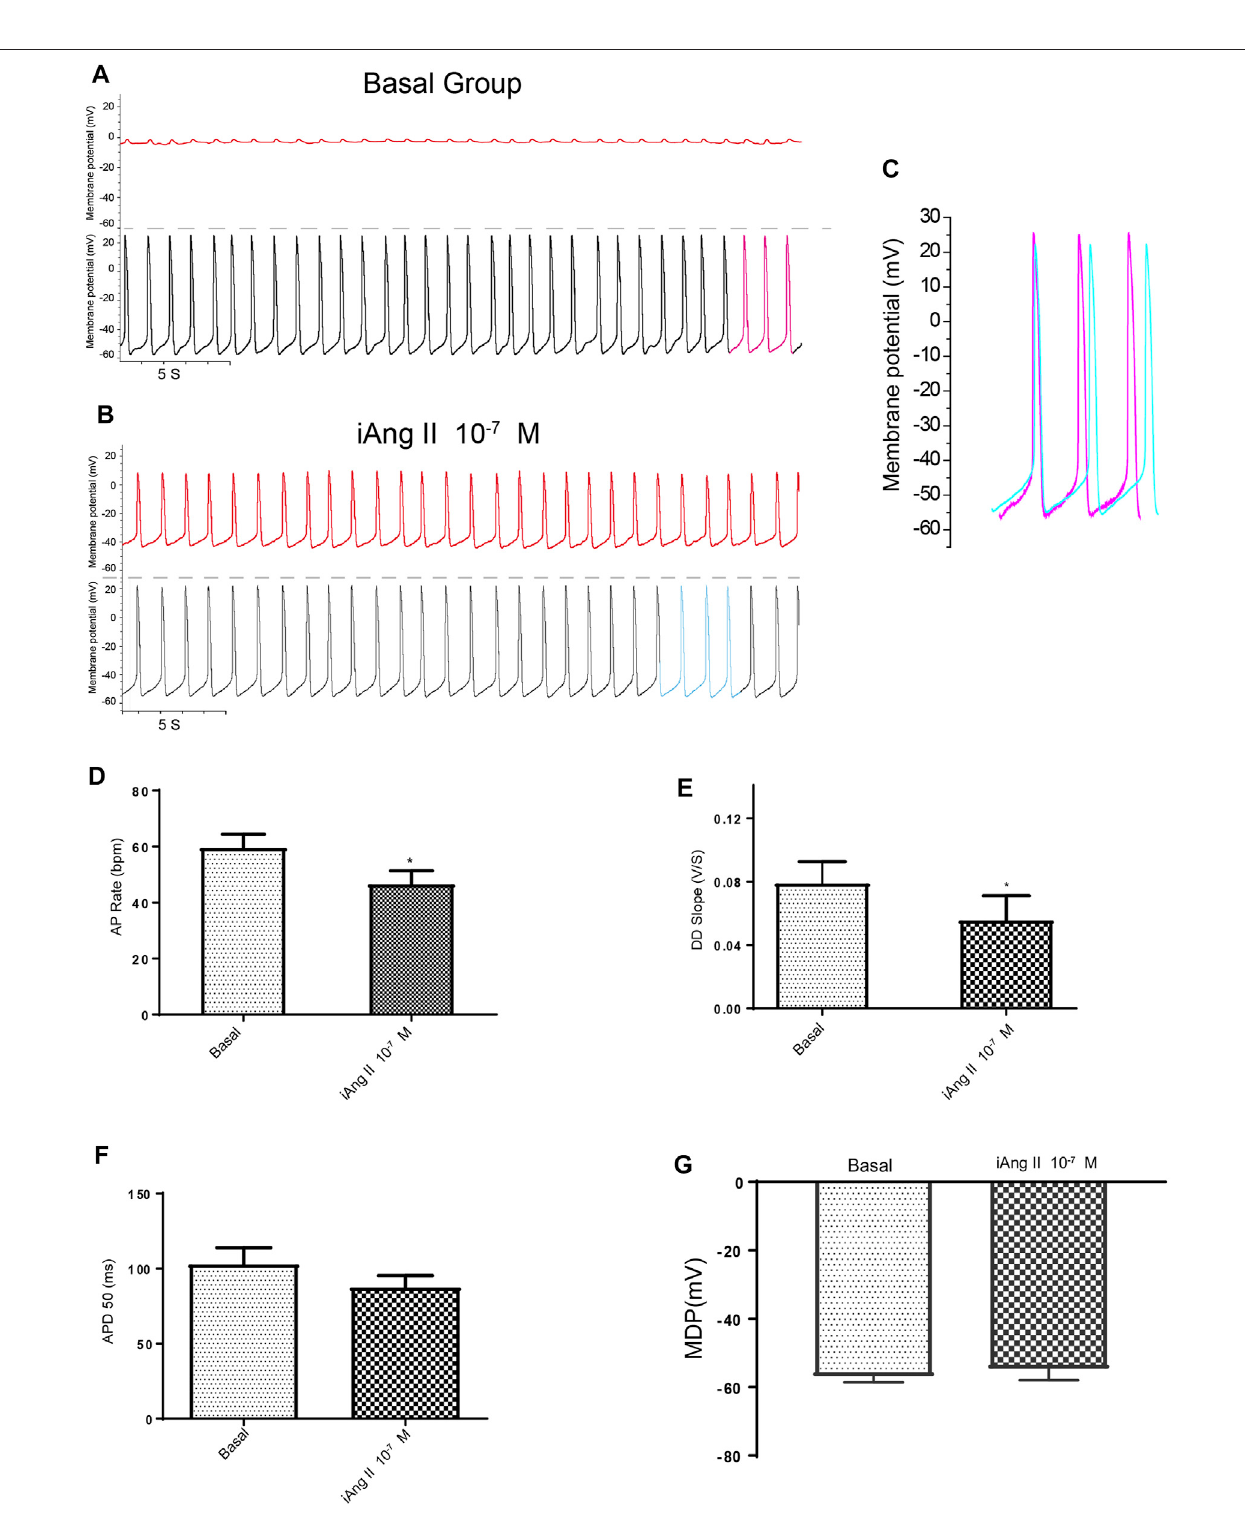
FIGURE 4 | iAng IIdecreased the APsof mESC-CMs in apersistentmanner. (A) Dual current patch clamp of APs of mESC-CMs without intracellular drug delivery (i.e., before membrane breakage by the “ drug electrode ” ). Upper panel represents recording in the “ drug electrode ” while the lower panel represents recording in the “ recording electrode. ” (B) Dual current patch clamp of APs of mESC-CMs with intracellular delivery of Ang II (i.e., after membrane breakage by the “ drug electrode ” ). Upper panel represents recording in the “ drug electrode ” while the lower panel represents recording in the “ recording electrode. ” (C) Traces labeled as pink in (A) (representsAPsbeforeiAngIIdelivery)andasbluein (B) (representsAPsafteriAngIIdelivery)areoverlaidforcomparison. (D – G) Summarizeddataonthe (D) APrate, (E) DD slope, (F) APD 50, and (G) MDP of APs upon treatment with iAng II. Values are mean ± SEM of 6 – 10 independent experiments. * p < 0.05 vs. control group.